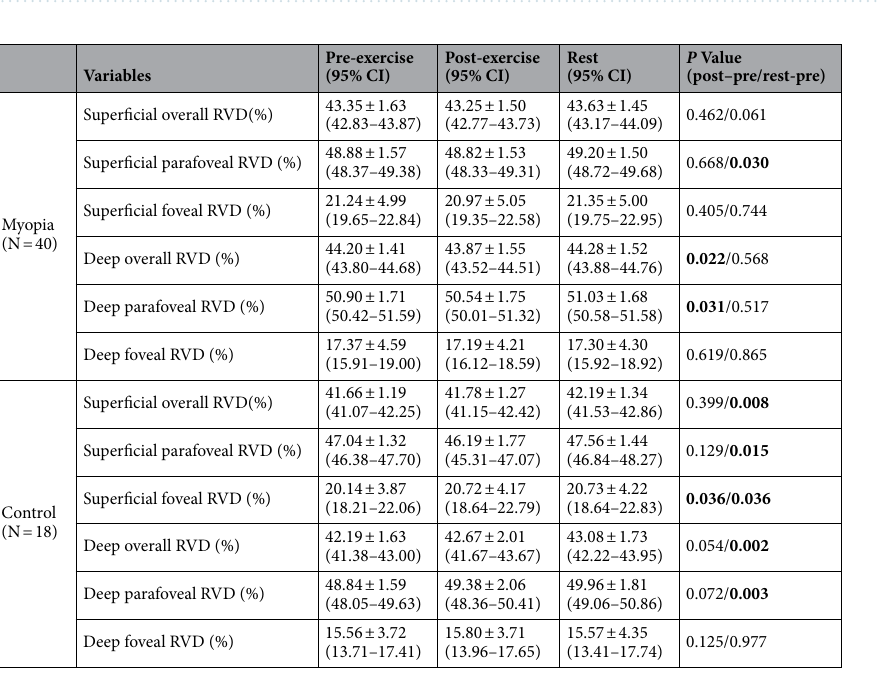
Table 1. Changes in RVD in the superficial and deep layers of myopic and emmetropic eyes before exercise, after 20 min of exercise, and after 30 min of rest. RVD retinal vessel density, CI confidence interval, post–pre comparisons by paired t tests for post-exercise vs. pre-exercise, rest-pre: comparisons by paired t tests for post- rest vs. pre-exercise. Bold values indicate statistical significance: p <